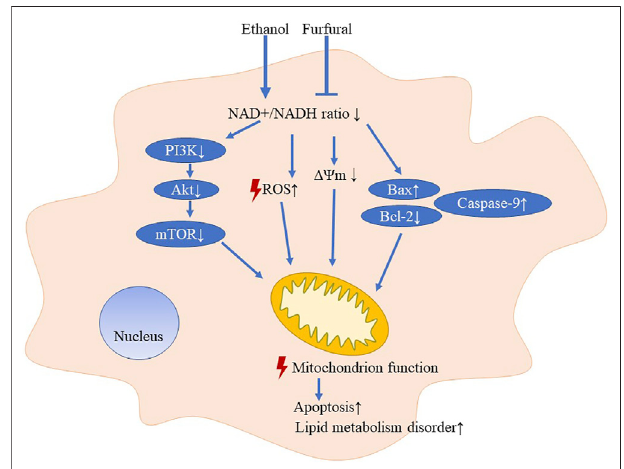
FIGURE5| Patterndiagramoflow-dosefurfuralinattenuatingeffectson ethanol-induced